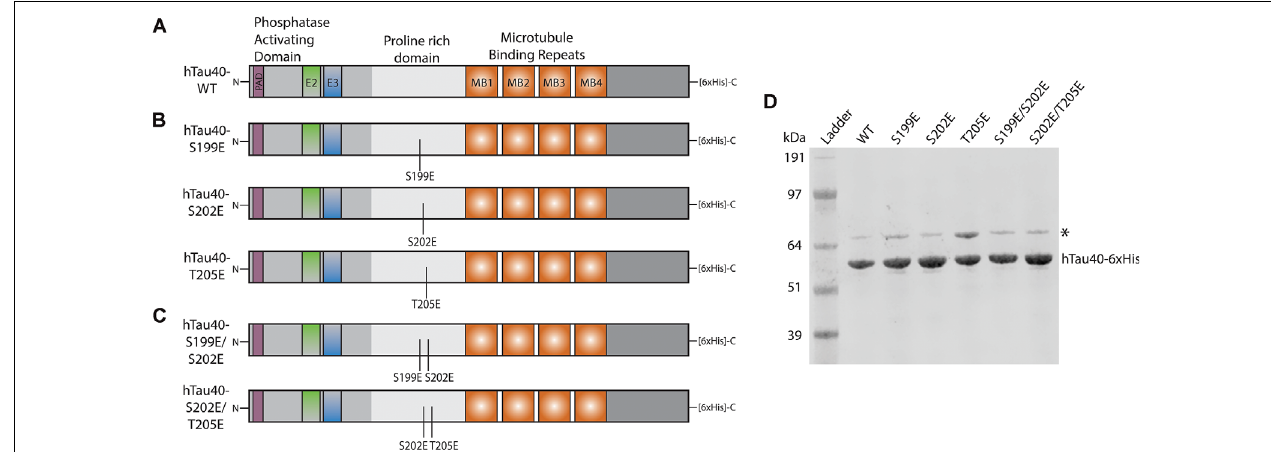
FIGURE 1 | Schematic of recombinant tau proteins used. (A) hTau40-WT corresponds to the longest isoform of human CNS tau containing two N-terminal inserts (exons 2 and 3) and four microtubule-binding repeats. (B) The hTau40-S199E, hTau40-S202E, and hTau40-T205E recombinant proteins were each pseudophosphorylated by a single point mutation (S → E or T → E) of the AT8 epitope. (C) The hTau40-S199E/S202E and hTau40-S202E/T205E recombinant proteins were pseudophosphorylated at two combinations of the individual mutation sites. (D) Each recombinant tau protein was run on SDS–PAGE (1 µ g/lane) and the gel was stained with Coomassie to show each protein. ∗ DnaK ( ∼ 70 kDa) copurifies with tau protein (Combs et al., 2017).